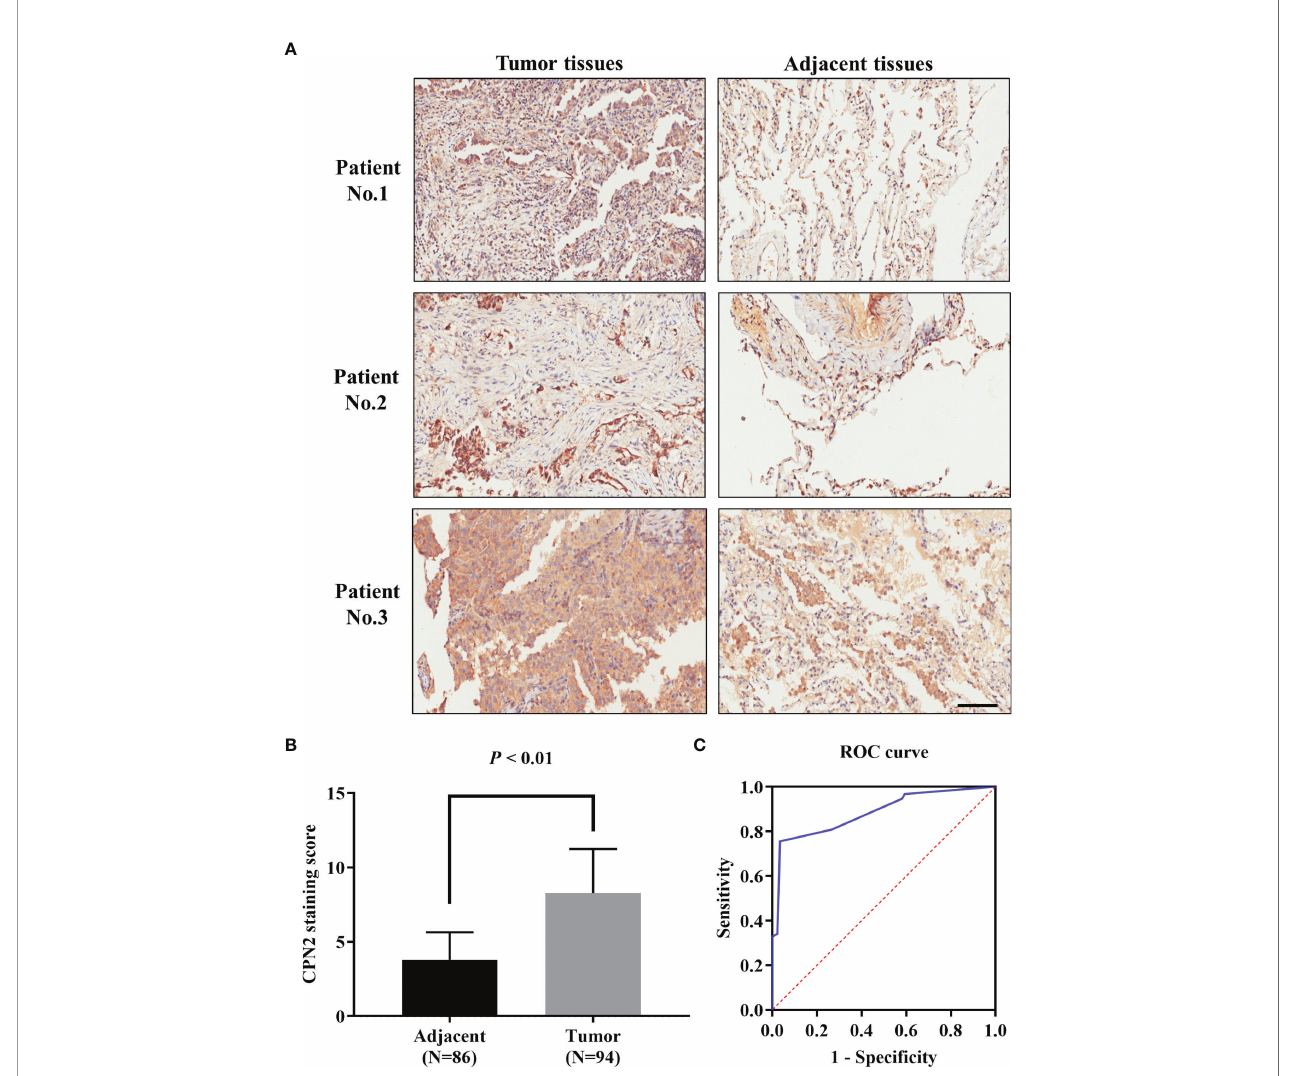
FIGURE 3 | CPN2 expression was signi fi cantly upregulated in clinical lung adenocarcinoma tissues. (A) Immunohistochemistry analysis of CPN2 expression levels in adjacent and lung adenocarcinoma tissues, with the scale bar equal to 100 m m. CPN2 was highly expressed in tumor tissues. Immunohistochemistry staining assays were performed with an anti-CPN2 antibody (magni fi cation, ×200). (B) CPN2 expression was signi fi cantly upregulated in lung adenocarcinoma tissues according to the total samples with a staining score. Two-tailed Wilcoxon test. (C) Receiver operating characteristic curve of CPN2 protein expression in clinical samples for the diagnosis of lung